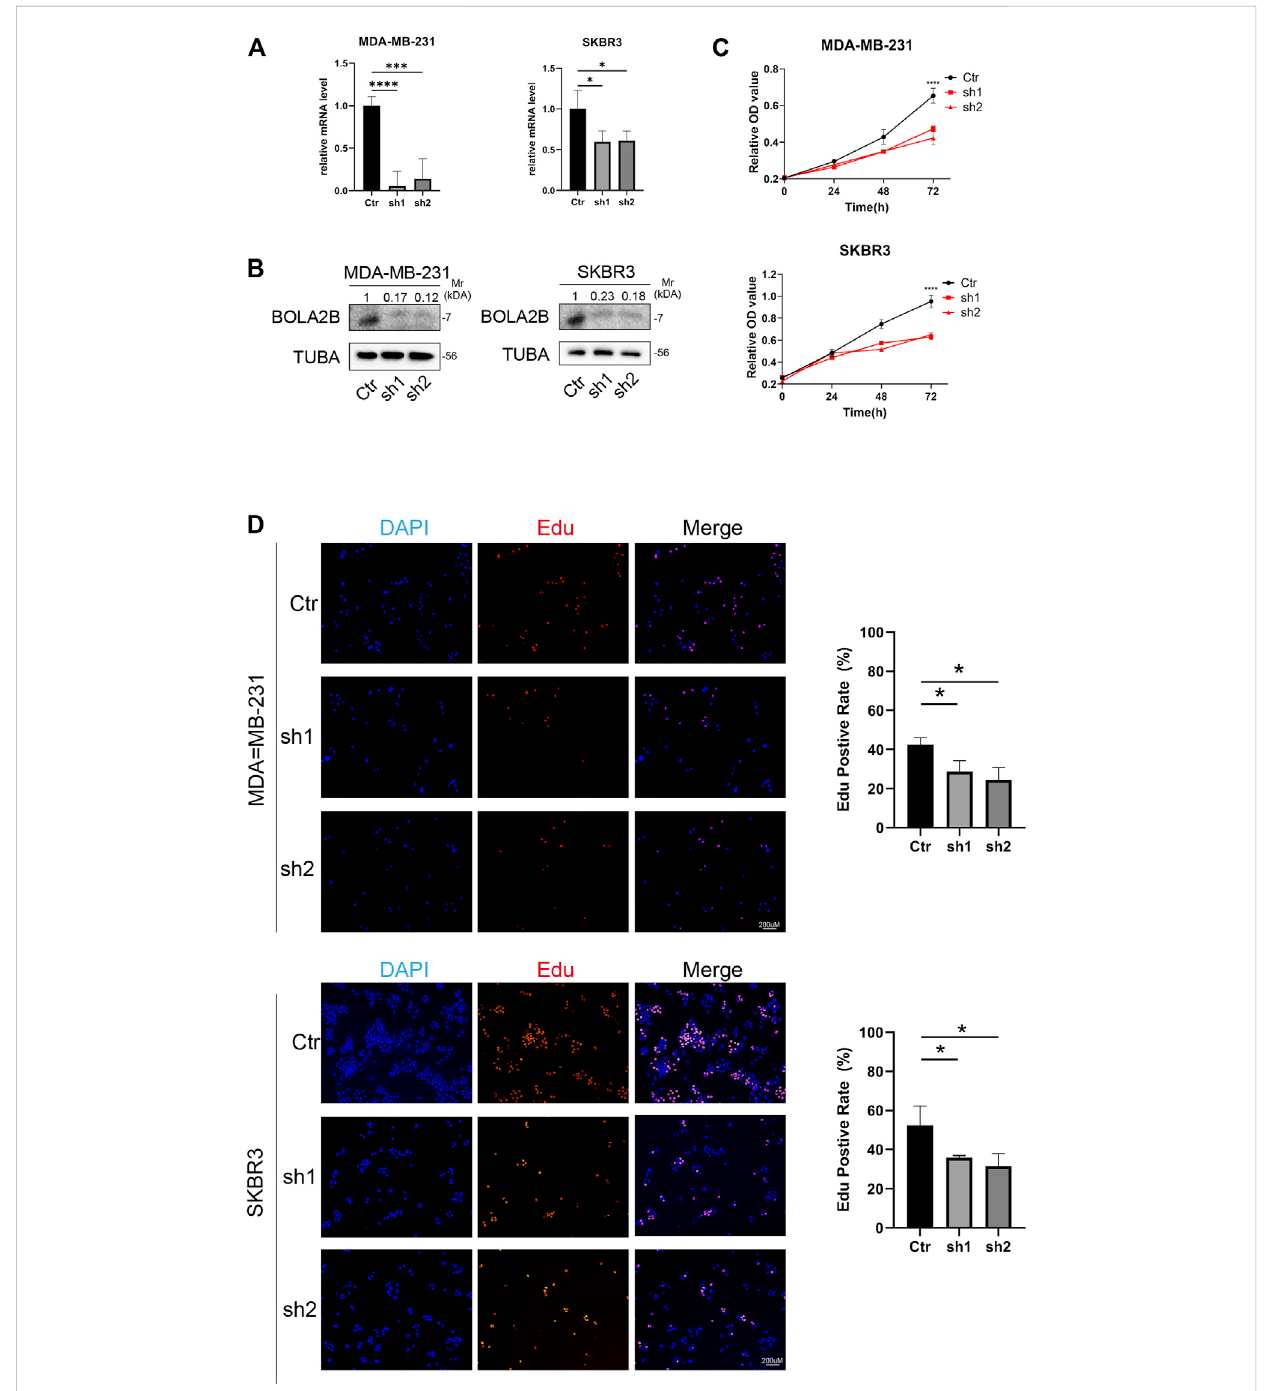
BOLA2B knockdown reduced breast cancer cell proliferation. (A) Relative mRNA level of BOLA2B knockdown in MDA-MB-231 and SKBR3. (B) Western blot of BOLA2B knockdown in MDA-MB-231 and SKBR3. (C) CCK-8 assay about the BOLA2B-shRNA group downregulated MDA-MB-231, and SKBR3 proliferation compared to the control group. (D) The EdU proliferation assay was performed, and the ratio of EdU-positive cell underwent statistical analysis. * p < 0.05, ** p < 0.01, and *** p <